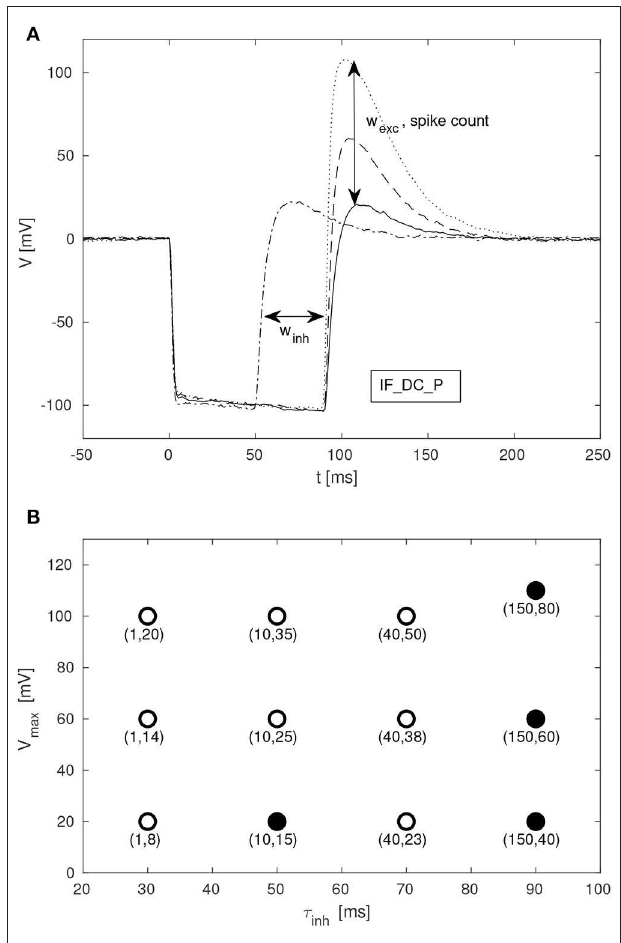
FIGURE 9 | Configuration of disynaptic delay elements. (A) Postsynaptic membrane potential vs. time, resulting from a presynaptic pulse. The delay is controlled mainly by the inhibitory synaptic efficacy, w inh . The amplitude of the delayed excitation is controlled mainly by the excitatory synaptic efficacy, w exc , and by the number of presynaptic spikes. Note that the membrane potential reaches its minimum possible value during inhibition, and that the difference between this value and the resting potential is controlled with the constant injection current of the neuron, controlled by the bias parameter IF_DC_P . (B) Maximum membrane potential, V max , vs. duration of inhibition, τ inh , for different values of ( w inh , w exc ). Each point is denoted with the corresponding fine integer bias values of the inhibitory and excitatory synaptic weights,